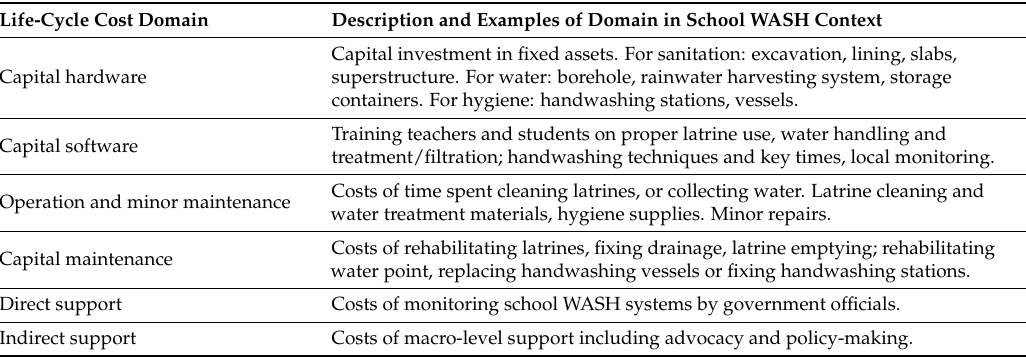
Table 1. Life-cycle cost domains and their descriptions in the context of school WASH, Kenya,